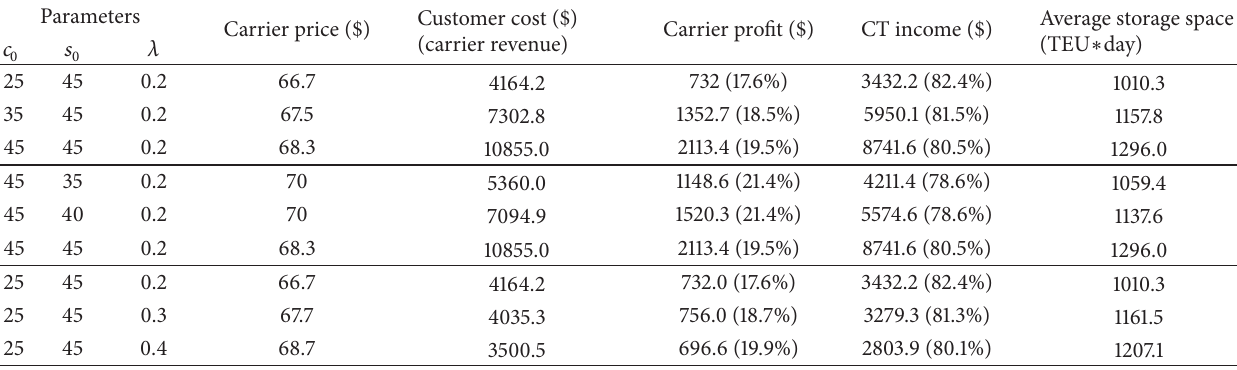
Table 3: Sensitivity analysis of free-time system under different 𝑐 0 , 𝑠 0 , and 𝜆